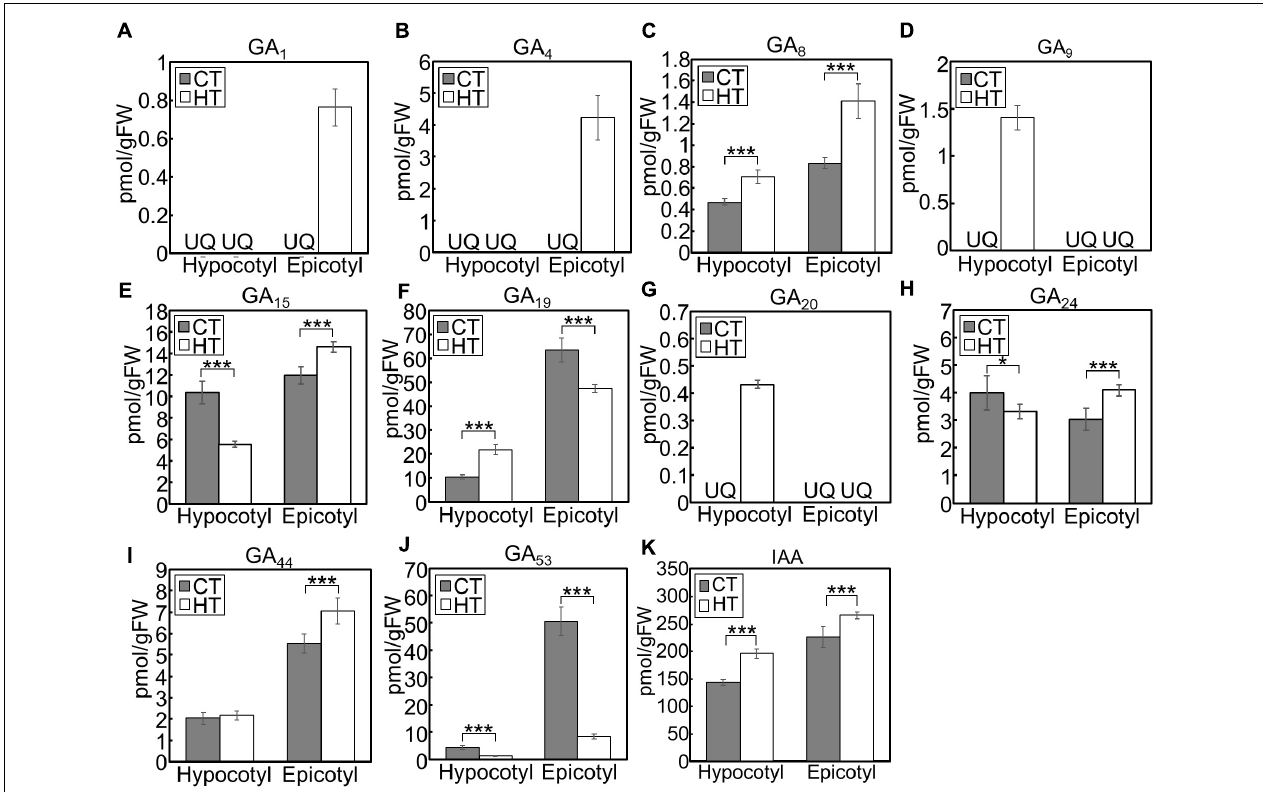
FIGURE 7 | GA and IAA concentration in hypocotyls and epicotyls under two different temperatures. Hypocotyls and epicotyls of tomato seedlings grown for 7 days under control and high temperatures were harvested and subjected to hormone analysis. The concentrations of GAs (A–J) and IAA (K) were quantified using liquid chromatography-tandem mass spectrometry. Data are represented as mean ± SD ( n = 4 or 5). * P < 0.1; *** P < 0.01 (Student’s t test). GA 7 and GA 12 were below the quantification limit. CT, control temperature; HT, high temperature; FW, fresh weight; UQ, under quantification